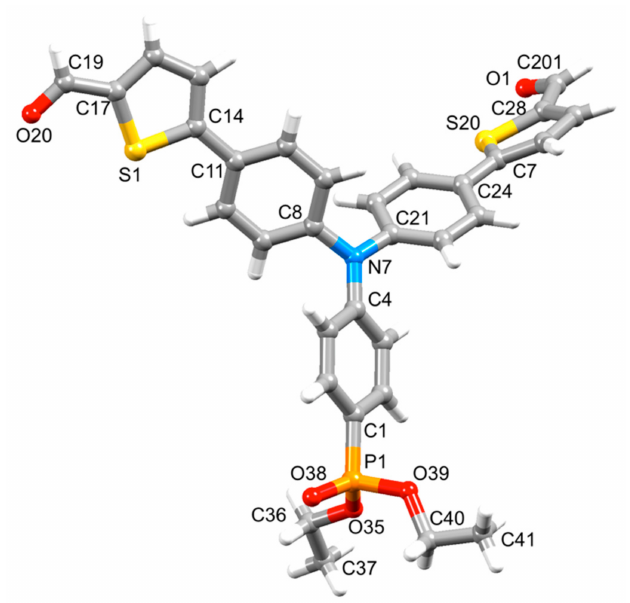
Figure 3. Single crystal structure of compound 3 ; an ORTEP-style plot in Figure S5. The thiophene unit containing S20 and C201 is the major occupancy site of the disordered unit (see text). Selected bond parameters: P1–O35 = 1.586(4), P1–O38 = 1.451(4), P1–O39 = 1.557(5), O20–C19 = 1.208(6),